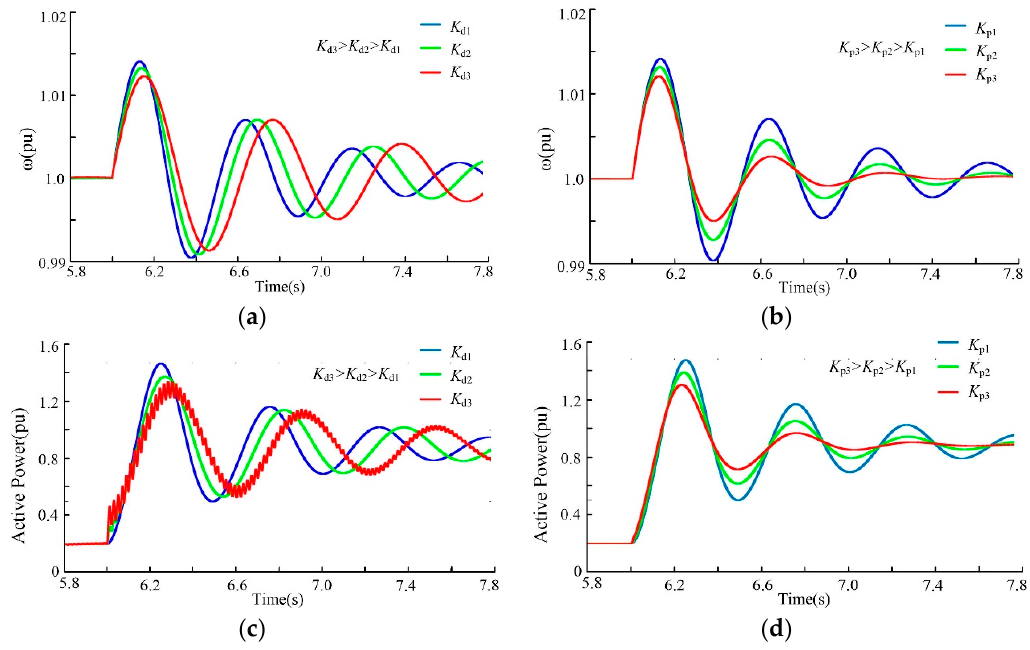
Figure 8. Effects of ESS controller parameters on system dynamics. ( a ) Frequency with D controller; ( b ) frequency with P controller; ( c ) SG power with D controller; ( d ) SG power with P controller.